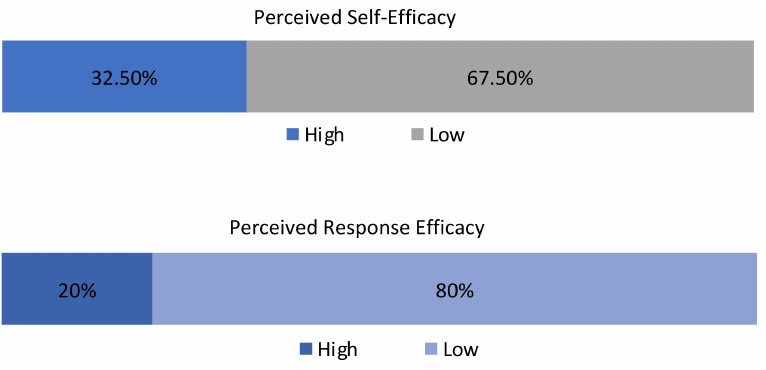
Figure 9. Perceived self and response